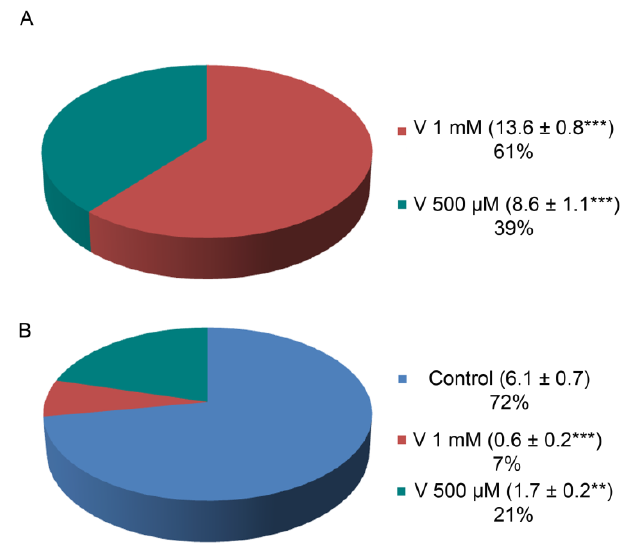
Figure 2. Amount of V and Ca incorporated in embryos after 48 h of development/treatment. Embryos were cultured under normal growth conditions and with V 1 mM or 500 µ M. ( A ) V and ( B ) Ca content. Values reported in the pie charts show the ionic concentrations detected for V ( µ g/g weight embryos) and Ca (mg/g weight embryos). Experiments were performed in triplicate and data are expressed as means ± standard deviation ( n = 3 ± SD). Statistical analysis was performed using t -test with ** p ≤ 0.01; *** p ≤ 0.0005.